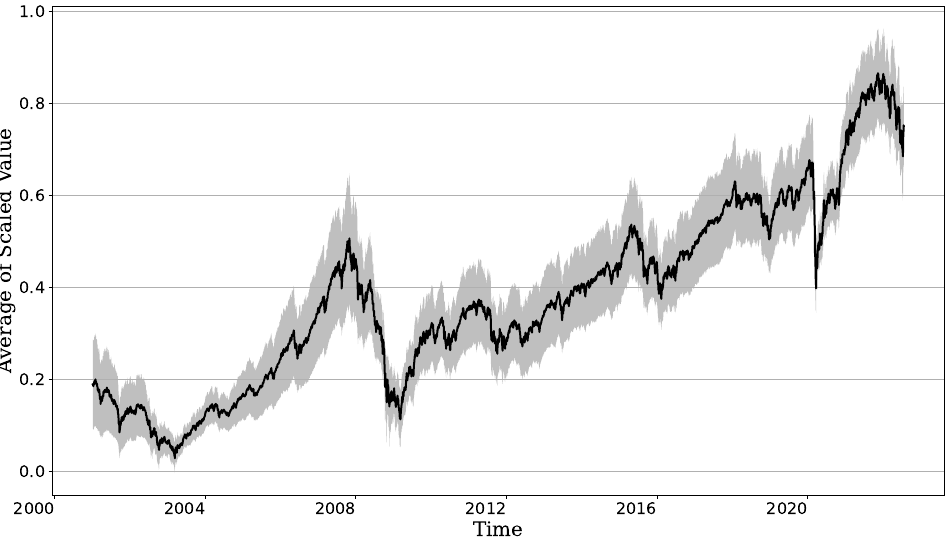
Figure 3. Time evolution of the average scaled value of all 27 market indices between Q1 2007 and Q2 2022 used in the study (gray shaded band means the standard error of the